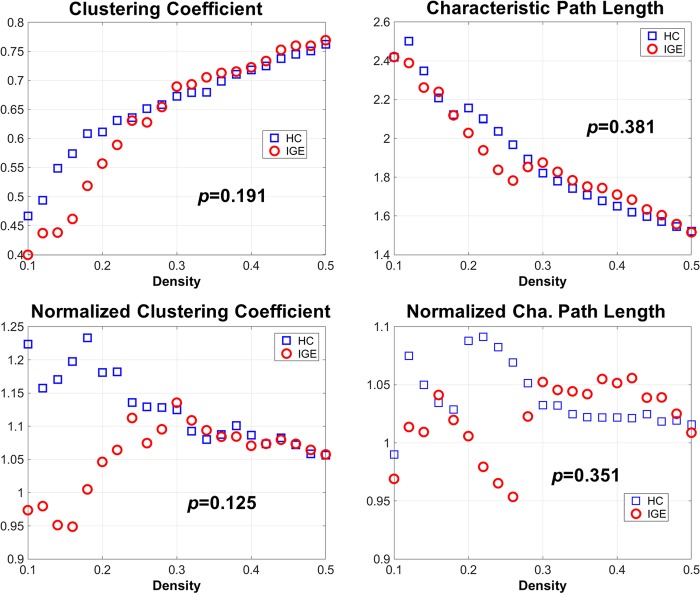
Network metrics and the p-values of AUC comparisons between the control and IGE groups.The meanings of the measures are described in the Methods section of the text.